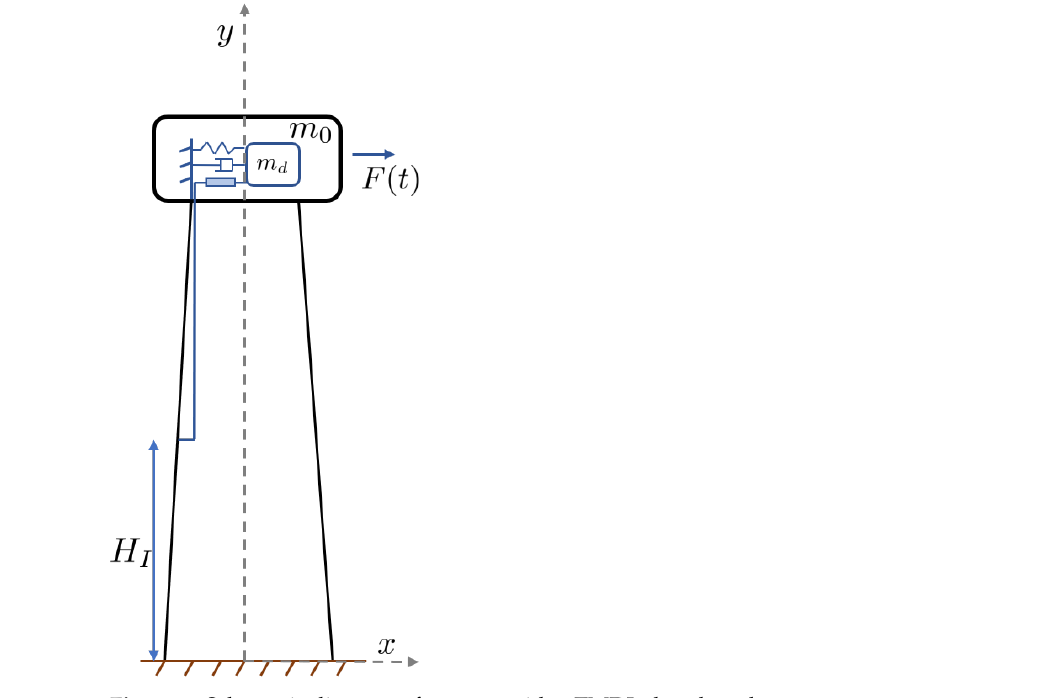
Figure 7. Schematic diagram of a tower with a TMDI placed on the